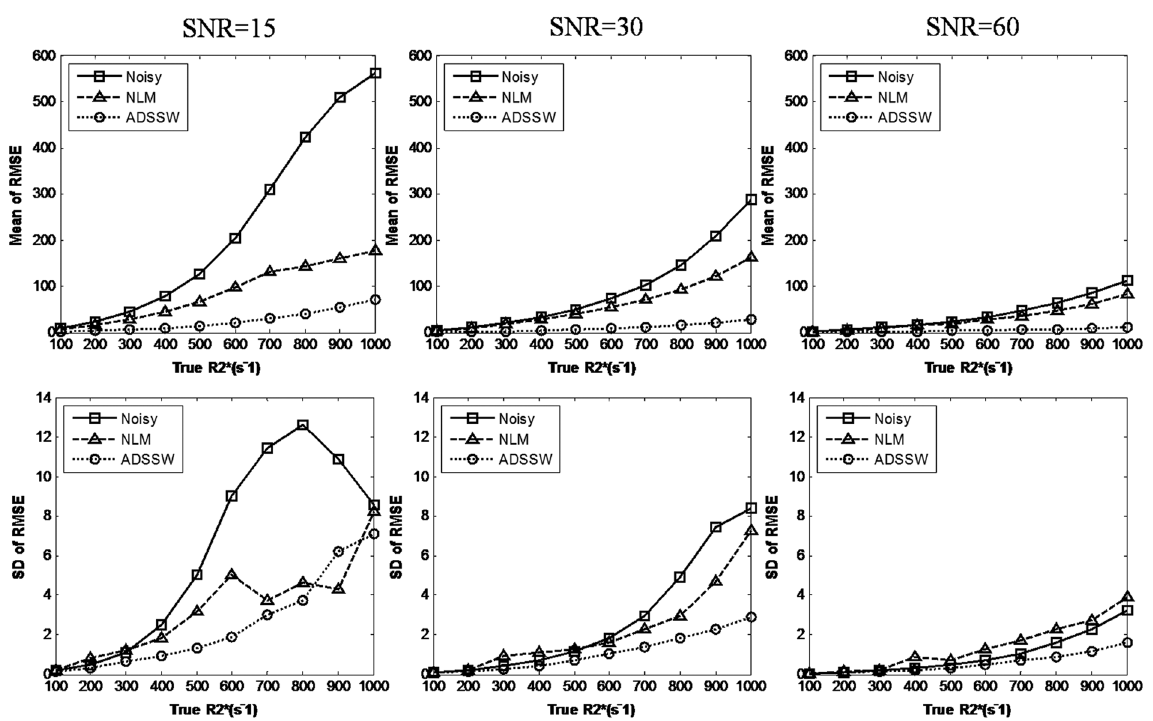
Figure 3. Plot of the means (top row) and SDs (bottom row) of the RMSEs of R2 * mapping from 200 realizations against the true R2 * values at varying noise levels (SNR = 15, 30 and